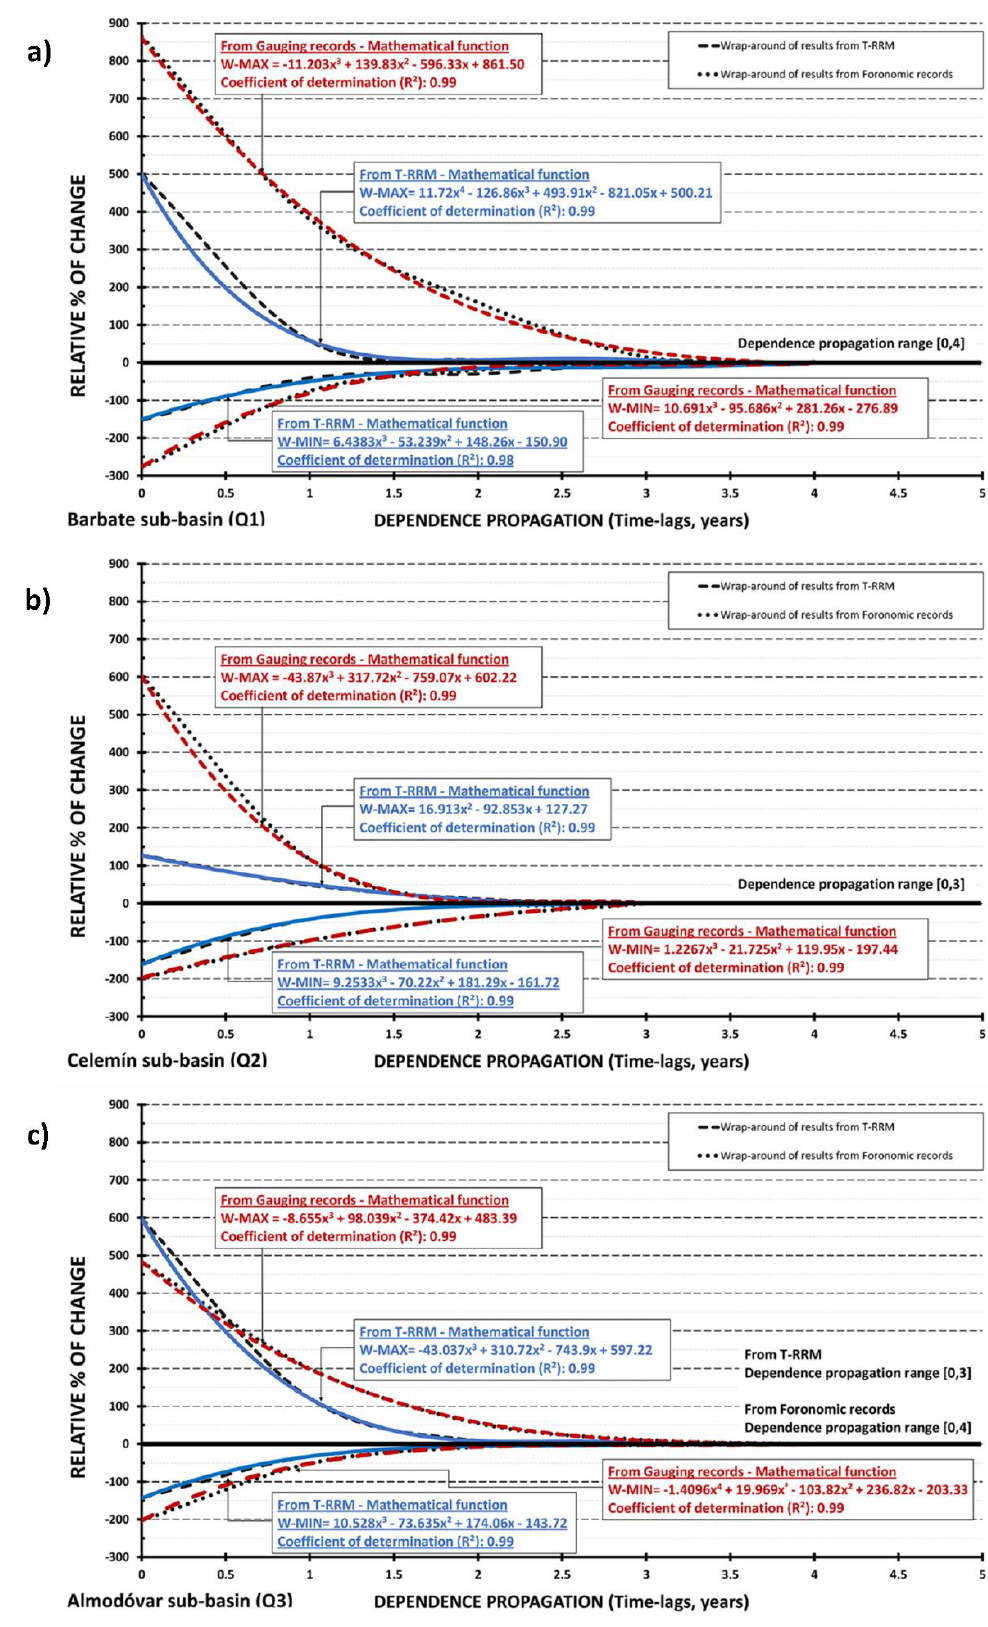
Figure 9. Dependence mitigation graphs (DMGs) for a short series (2000–2015). Comparison of causal model results from T-RRM versus gauging records: ( a ) Barbate Q1 sub-basin; ( b ) Celemín Q2 sub-basin; ( c ) Almodóvar Q3 sub-basin).